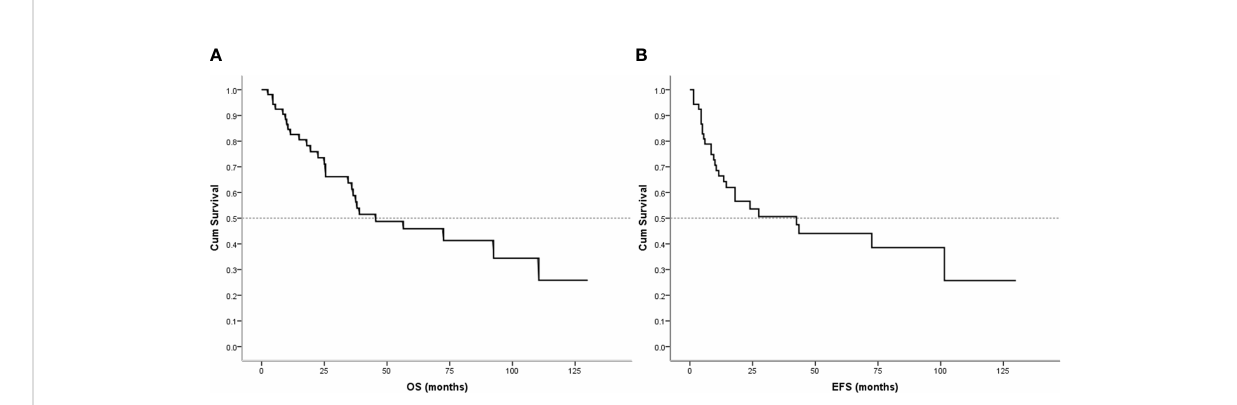
FIGURE 2 Survival curves for OS and EFS. (A) Survival curves for OS. (B) Survival curves for EFS.